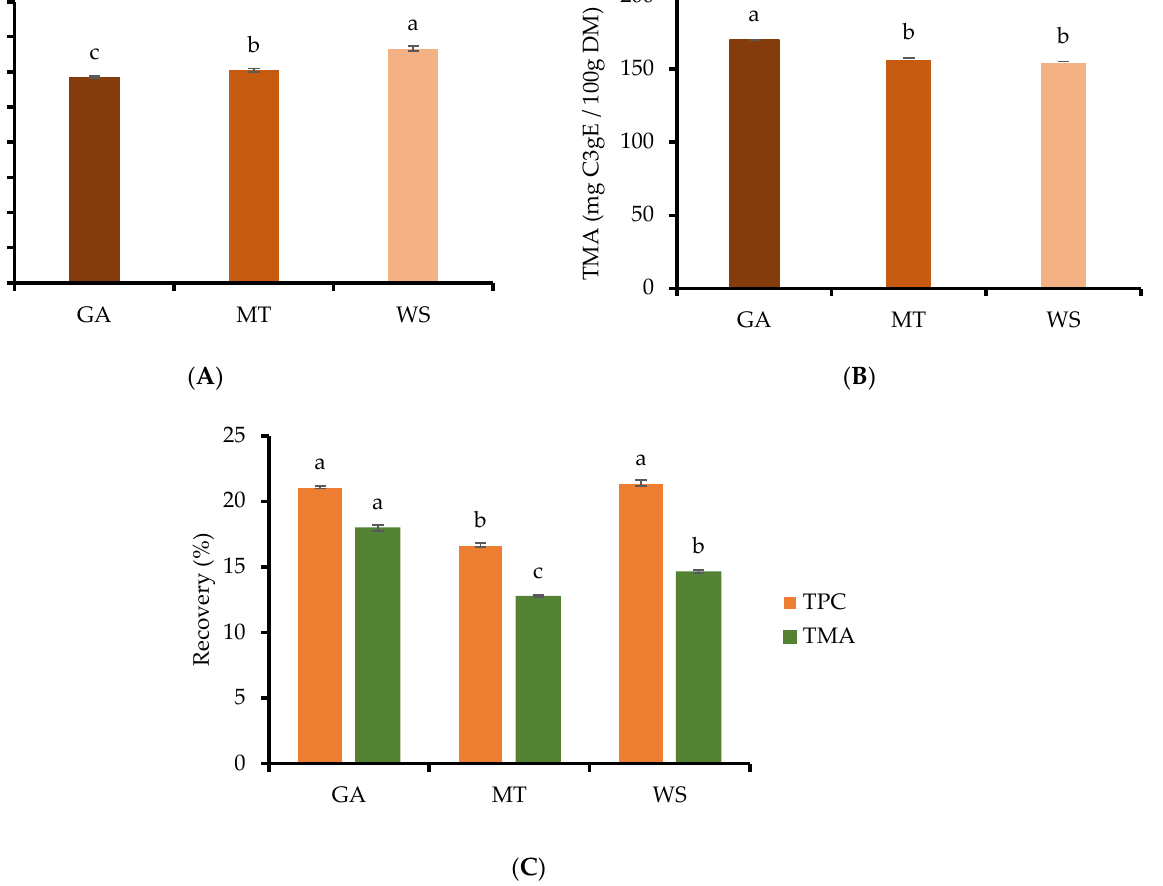
Figure 2. ( A ) Total phenolic content (TPC), ( B ) Total monomeric anthocyanin (TMA), and ( C ) recovery of raspberry juice freeze-dried powders developed using different carriers. Bars followed by different letters are significantly different ( p < 0.05) according to Duncan multiple range test. Vertical bars indicate the standard deviation of the mean. GA—gum Arabic; MT—maltodextrin; WS—waxy starch.